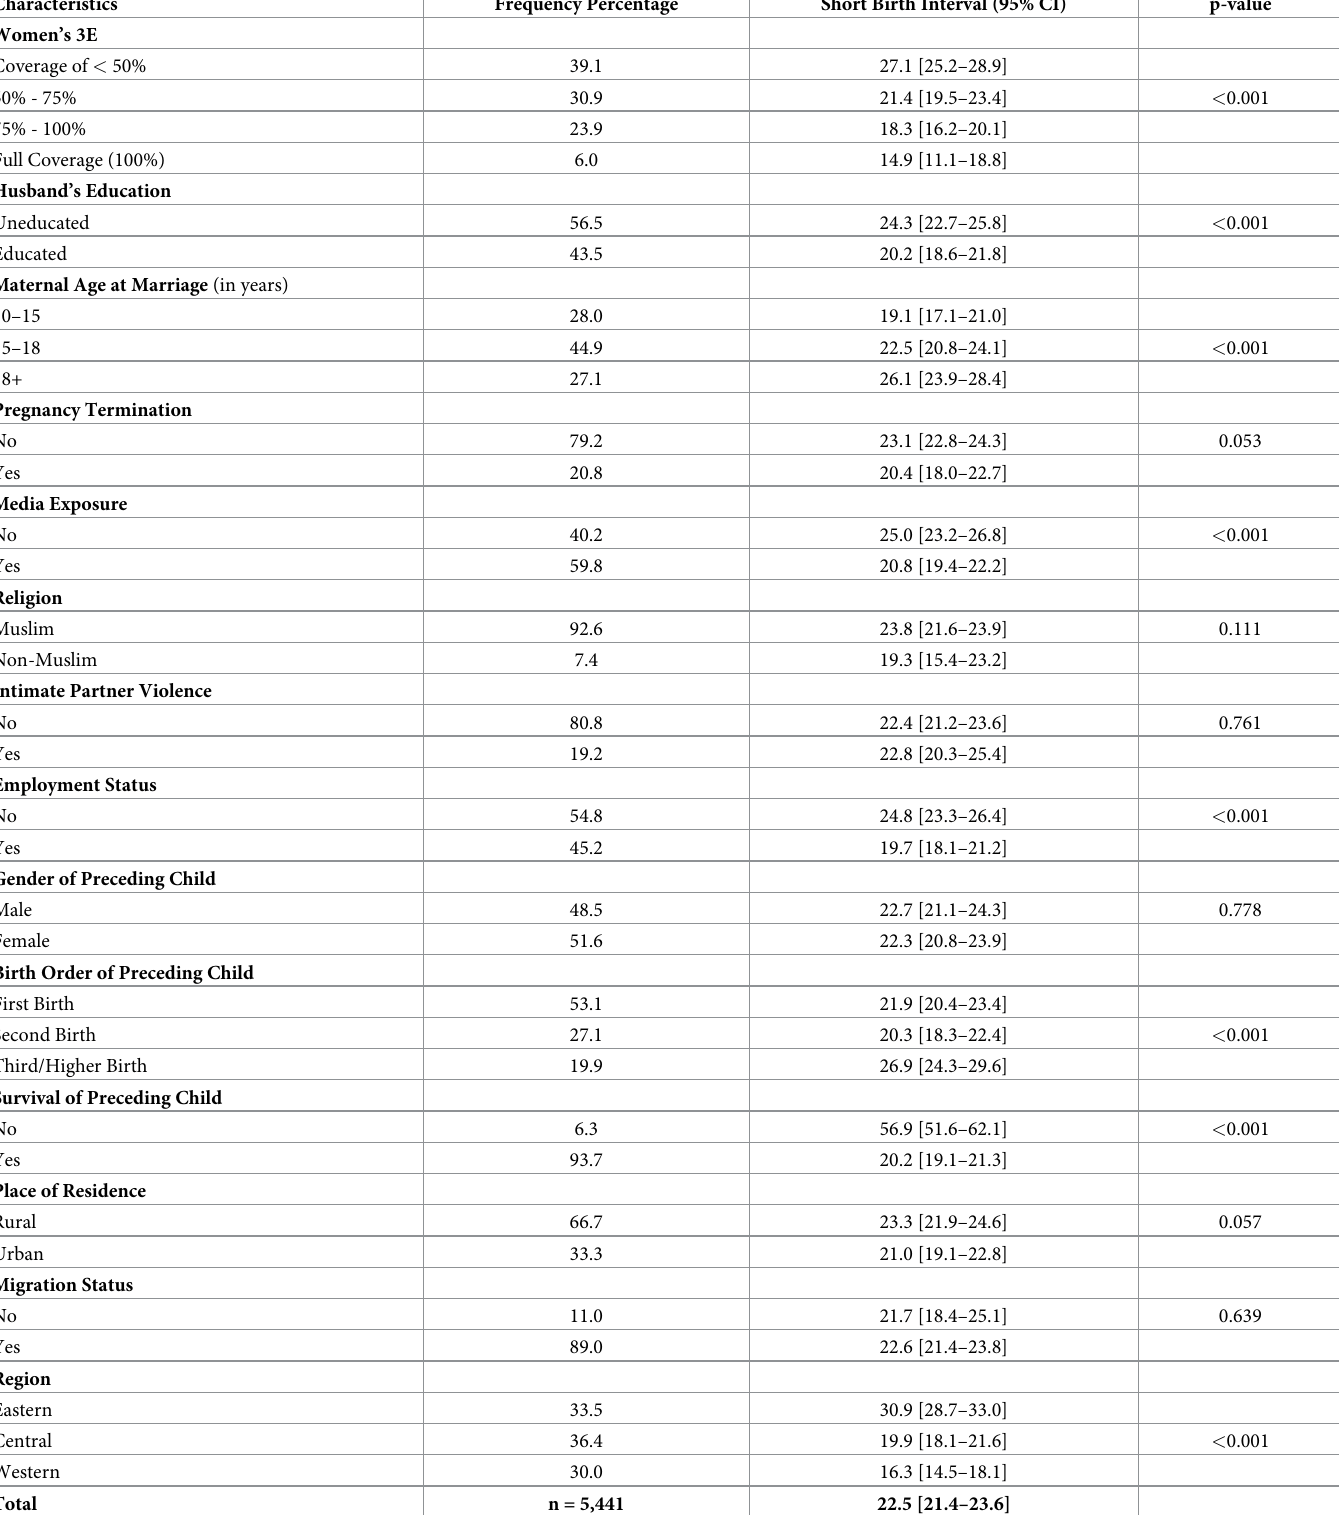
Table 3. Frequency percentage, and short birth interval with 95% confidence intervals (CI) by the selected background characteristics.